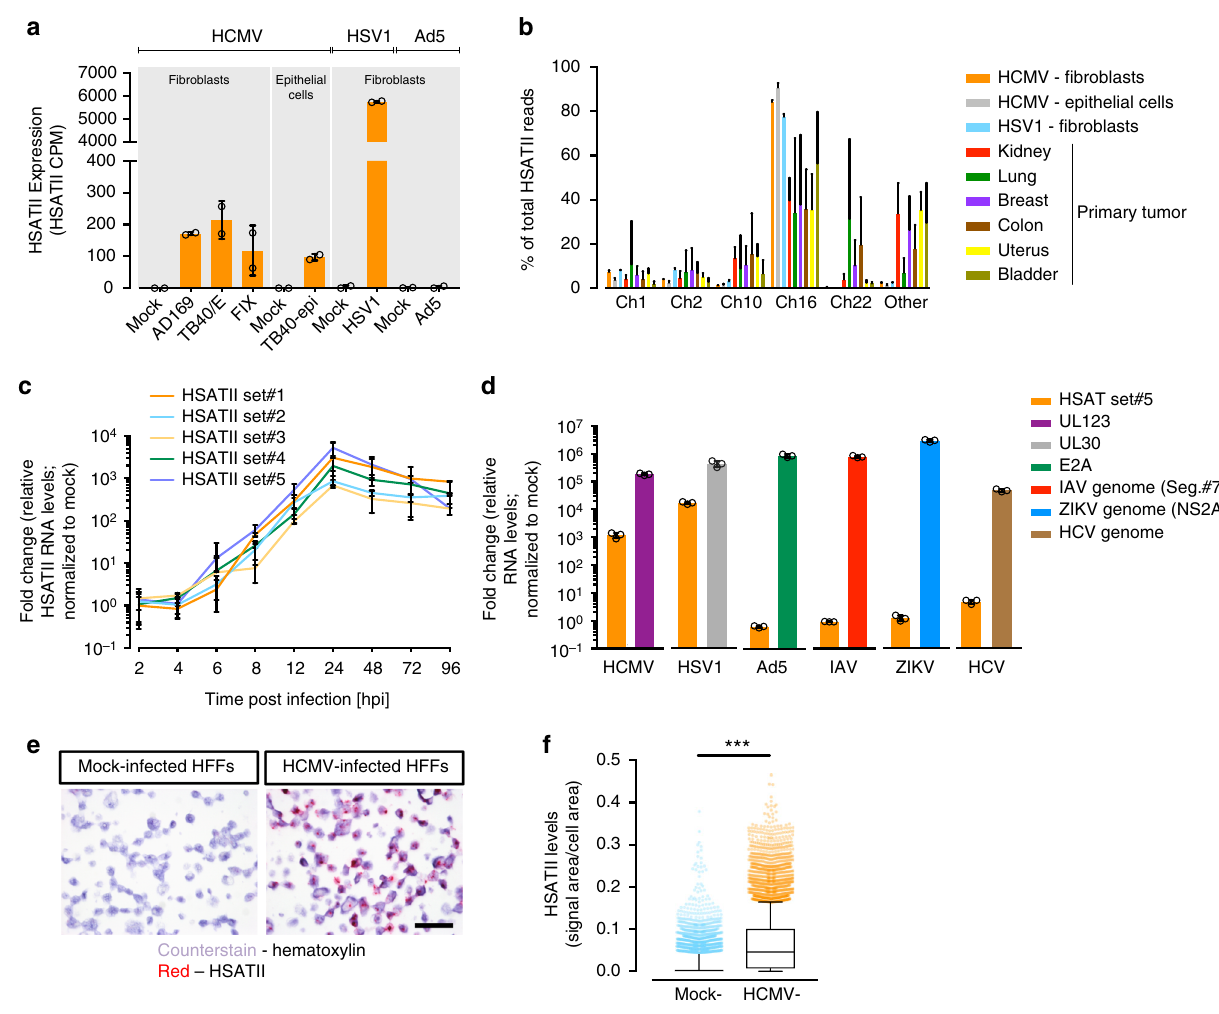
Fig. 1 HCMV and HSV1, but not ADV, FLU, ZIKV, HCV, induce HSATII expression. HFFs were infected with HCMV (3 TCID 50 /cell), HSV (3 TCID 50 /cell), or Ad5 (10 FFU/cell), and RNA samples were collected at 48, 9, or 24 hpi, respectively. RNA was isolated and analyzed using RNA-seq. a HSATII expression in terms of counts per million reads (CPM) was computed and normalized across samples. n = 2. b HSATII chromosomal origin in infected cells or primary tumors was depicted based on the number of unique HSATII reads mapped to speci fi c chromosomal loci. Data are presented as a percentage of total HSATII reads mean ± SD. n = 2. Open circles represent single data points. c HFFs were infected with HCMV (TB40/E-GFP) at 3 TCID 50 /cell and RNA samples were collected at the indicated times. HSATII-speci fi c primers were used in RT-qPCR analysis. GAPDH was used as an internal control. Data are presented as a fold change mean ± SD. n = 3. d Fibroblasts were infected with HCMV (3 TCID 50 /cell), HSV1 (3 TCID 50 /cell), Ad5 (10 FFU/cell), FLU (3 TCID 50 /cell), or ZIKV (10 PFU/cell), and Huh7 cells were infected with HCV (1 TCID 50 /cell). RNA samples were collected at 9 hpi (HSV) or 24 hpi (all other viruses). HSATII-speci fi c primers were used in RT-qPCR analysis. Viral infection was controlled by probing for a presence of viral transcripts: UL123 (HCMV), UL30 (HSV1), E2A (Ad5) or viral genomes: IAV and ZIKV. GAPDH was used as an internal control. Data are presented as a fold change mean ± SD. n = 3. Open circles represent single data points. e Mock- and HCMV (TB40/E-GFP)-infected HFFs at 3 TCID 50 /cell were collected at 24 hpi and HSATII RNA was visualized by ISH assay. Nuclei were counterstained with hematoxylin and HSATII is shown as red dots. Scale bar: 50 µ m. f HSATII signal from ISH staining was quanti fi ed based on the ratio of HSATII signal area to cell area using BDZ 6.0 software and is presented in box plots (a central line shows median and bounds of box the 25th and 75th percentiles) with 10 – 90 percentile whiskers. Dots represent outliers. n = 3. *** P < 0.001 by the unpaired, two-tailed t